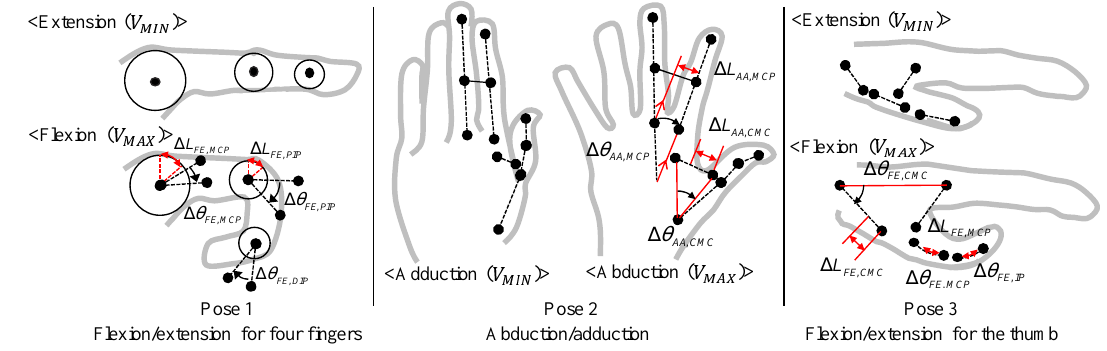
Figure 14. Calibration procedures.